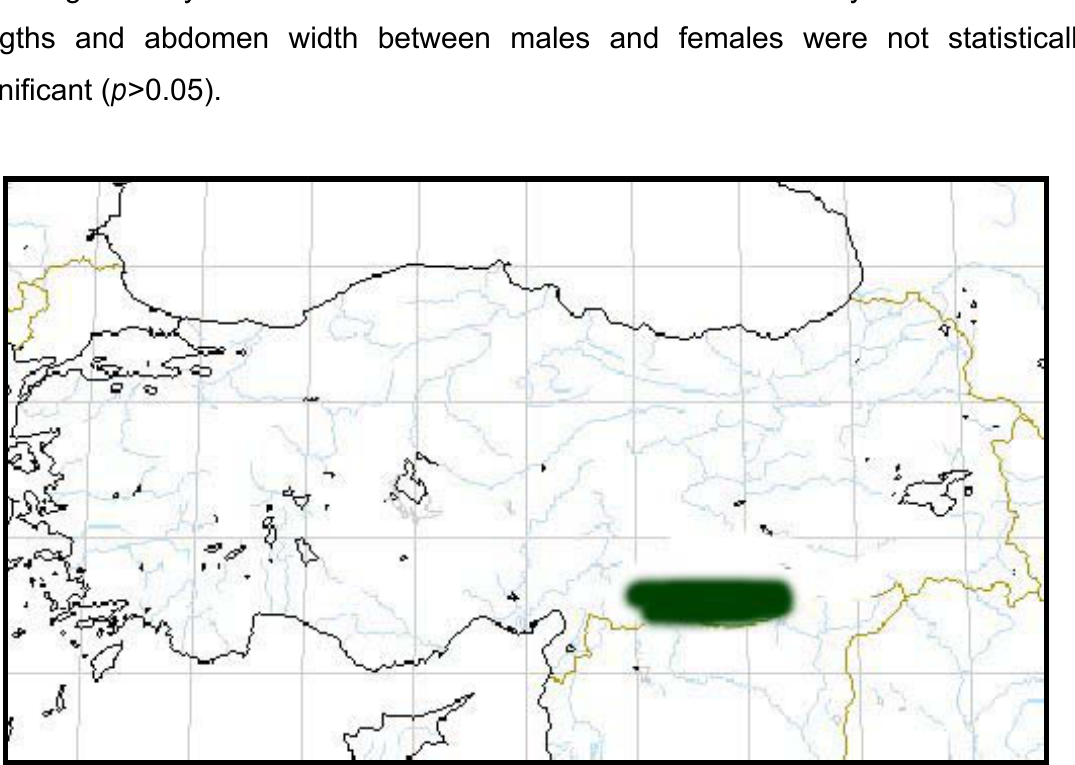
Figure 1: Map of Turkey highlighting Sanliurfa (36° 40’ - 38° 02’ W and 37° 50’ - 42° 12’ E) and close localities of Androctonus crassicauda occurrence in Southeastern